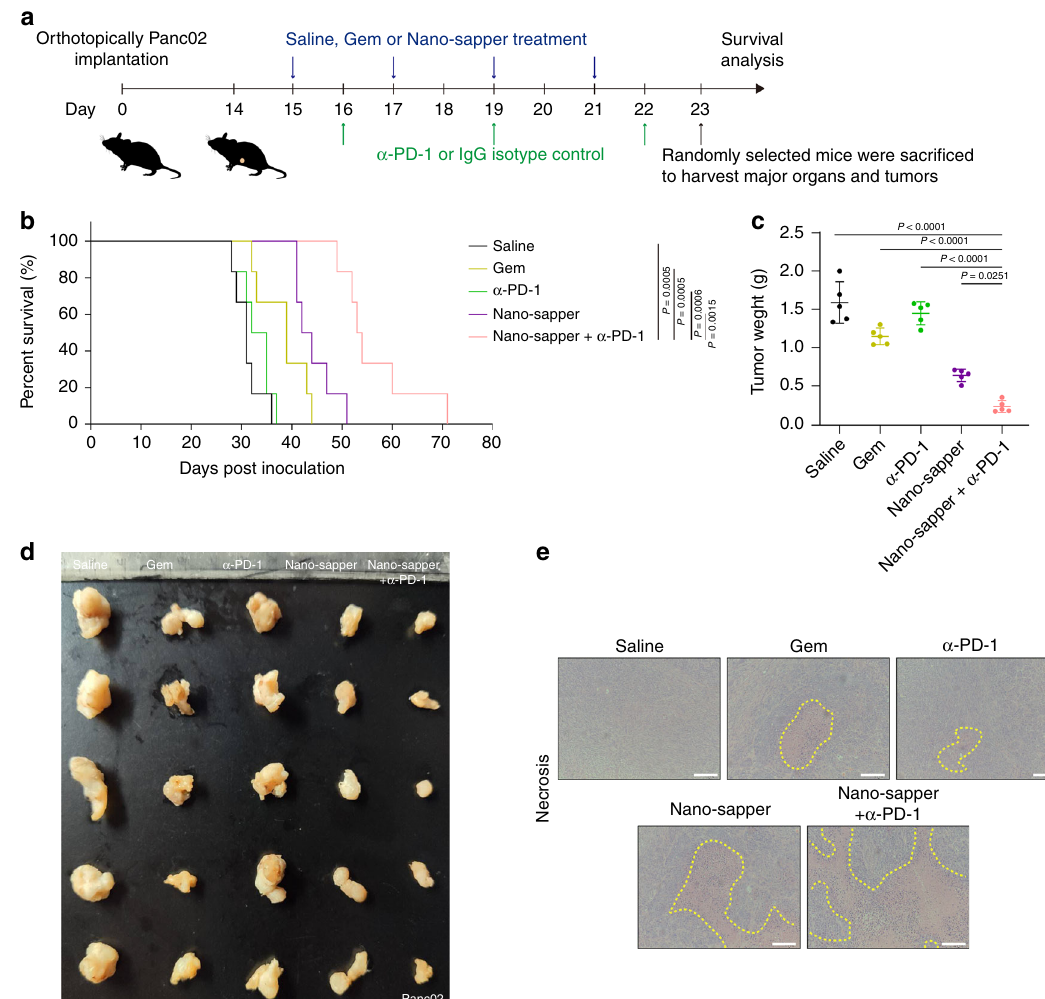
Fig. 8 Nano-sapper synergized with α -PD-1 to prolong the survival of Panc02 PDAC-bearing mice. a Six-week-old male C57BL/6 mice were orthotopically inoculated with Panc02 (1 × 10 6 ) on day 0. Saline, Gem (15 mg/kg) and Nano-sapper (MP = 13.9 mg/kg, 25 μ g plasmid per mouse) were i.v. administered every other day and α -PD-1 or IgG isotype (200 μ g per mouse) were i.p. administered every 2 days ( n = 12 mice). One day after the fi nal α - PD-1 treatment, fi ve mice were randomly sacri fi ced to extract tumors and major organs, b Mice survival curves in each treatment group ( n = 6 mice). c , d Tumor inhibition of different treatments ( n = 5 mice). e H&E staining histology of tumor necrosis. Scale bars, 100 μ m. Data are presented as mean ± s.d. One-way ANOVA with Bonferroni multiple comparisons post-test was used for ( c ). Kaplan – Meier analysis with log-rank Mantel-Cox test (two-sided) was used for b . Error bars